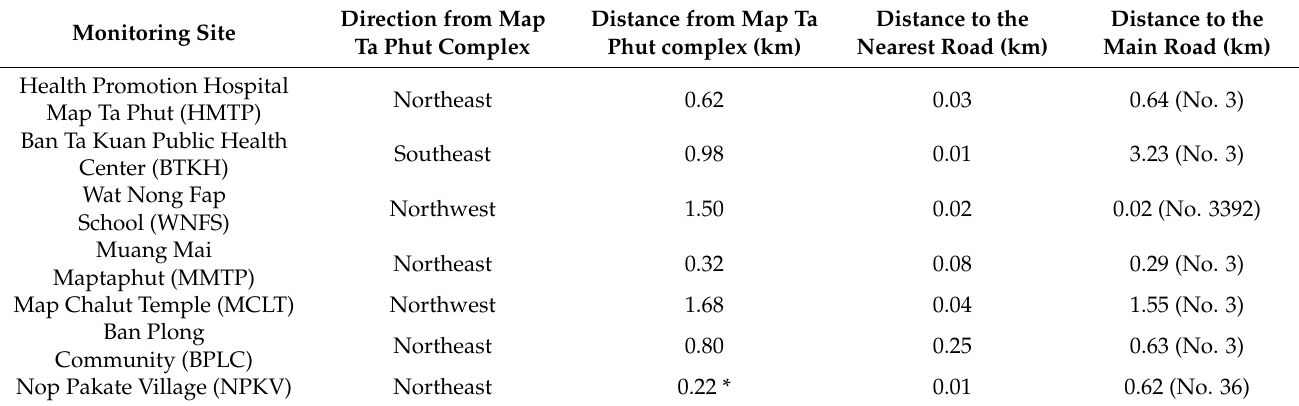
Table 1. Information on site characteristics in the community